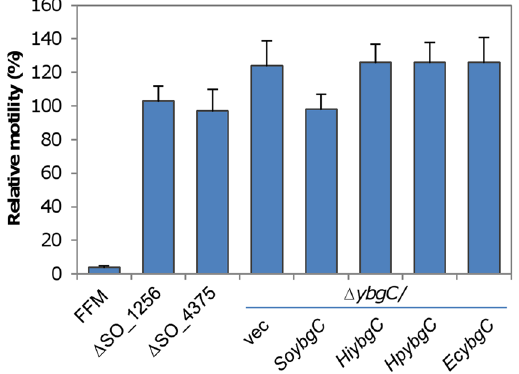
Figure 5. Unique features of SoYbgC may account for its regulatory role in motility. Effect of various thioesterases on motility. Various thioestereases, including YbgC proteins from E. coli , H. influenzae , and H. pylori , under P tac were expressed in the ∆ ybgC strain in the presence of 0.05 mM IPTG. The experiment was performed at least three times with SEM presented as error bars.